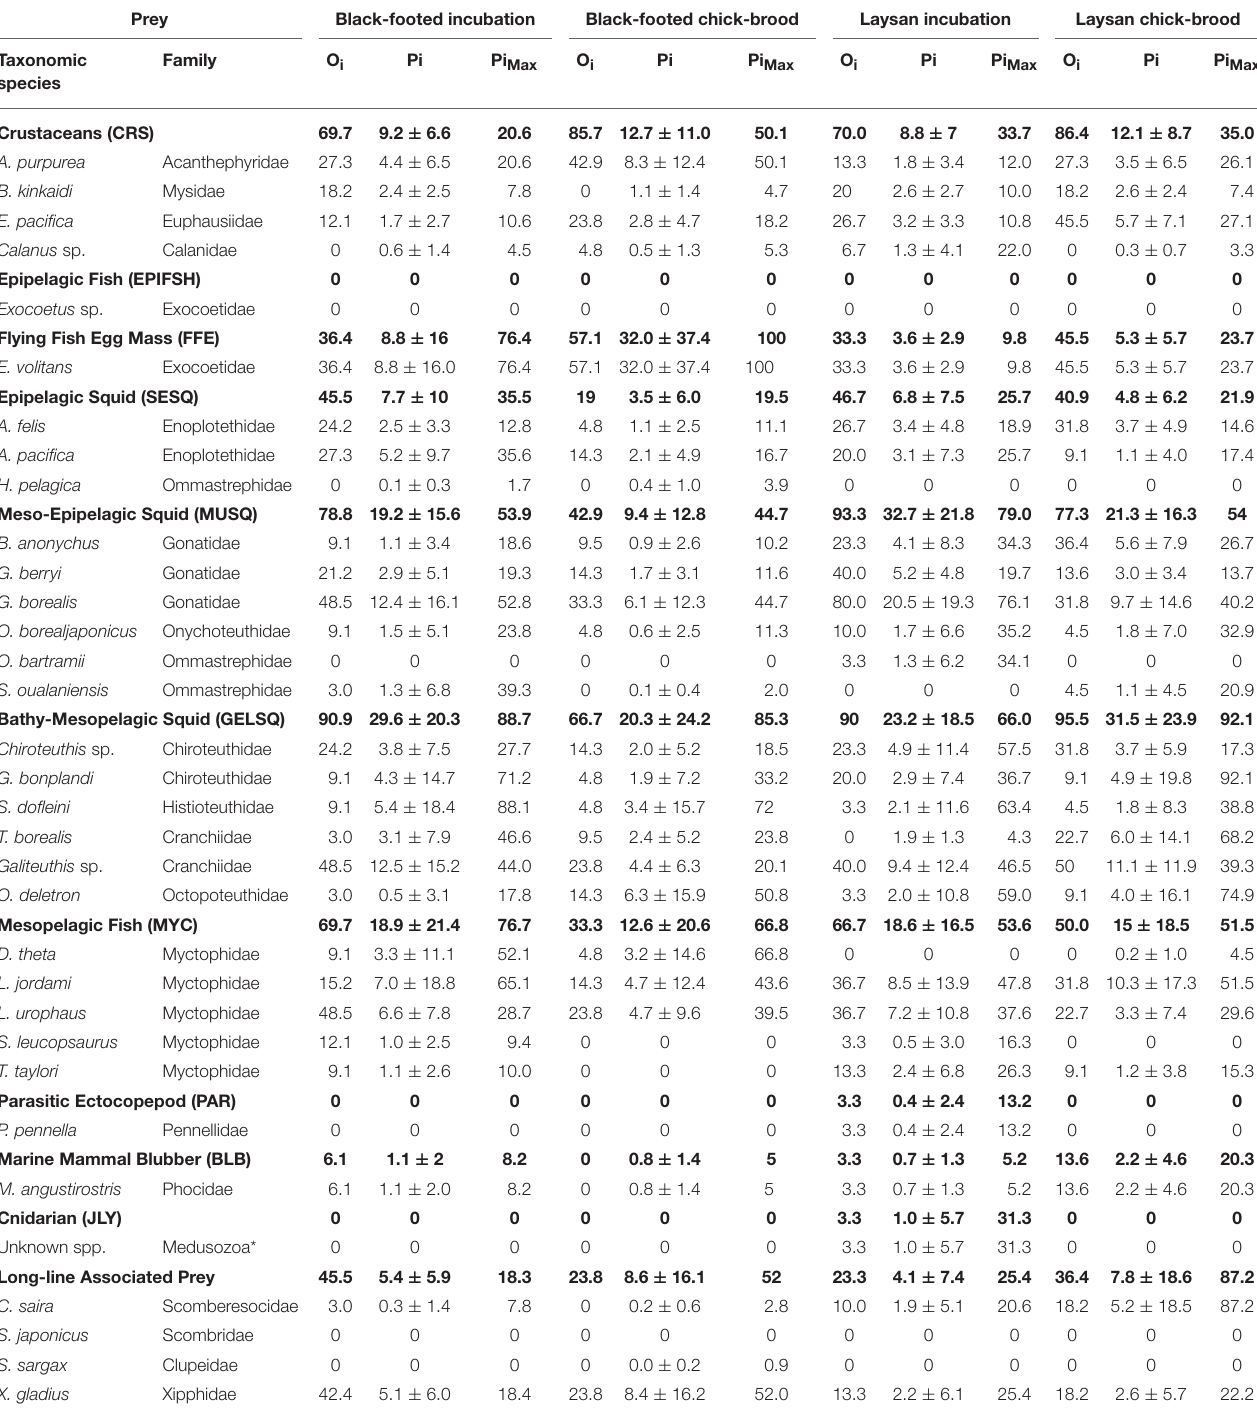
TABLE 2 | Diet characterization of breeding Hawaiian albatrosses from QFASA diet estimations. Prey Black-footed